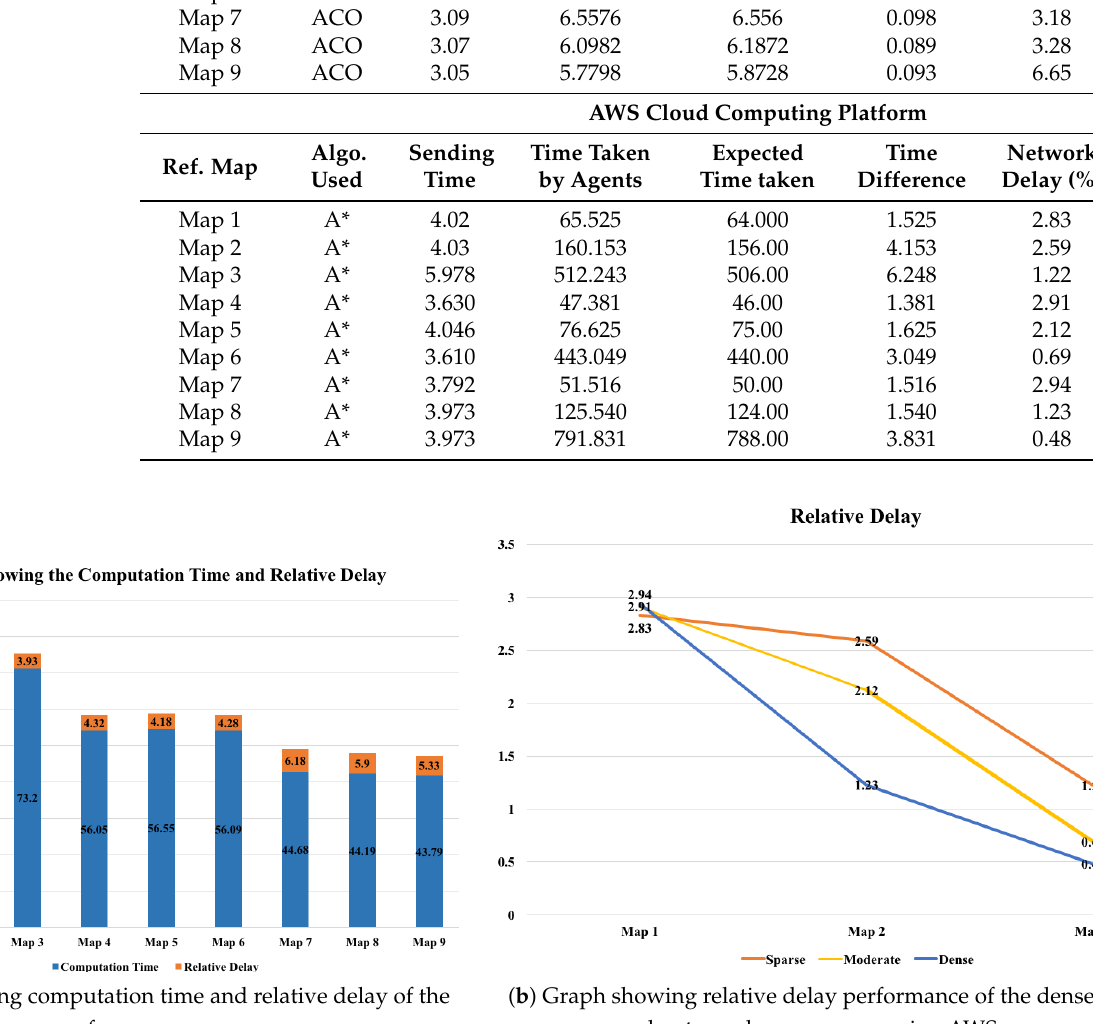
Figure 8. Output of path planning using A* Star algorithms with a local machine ( a ) and Google Cloud Computing Platform ( b